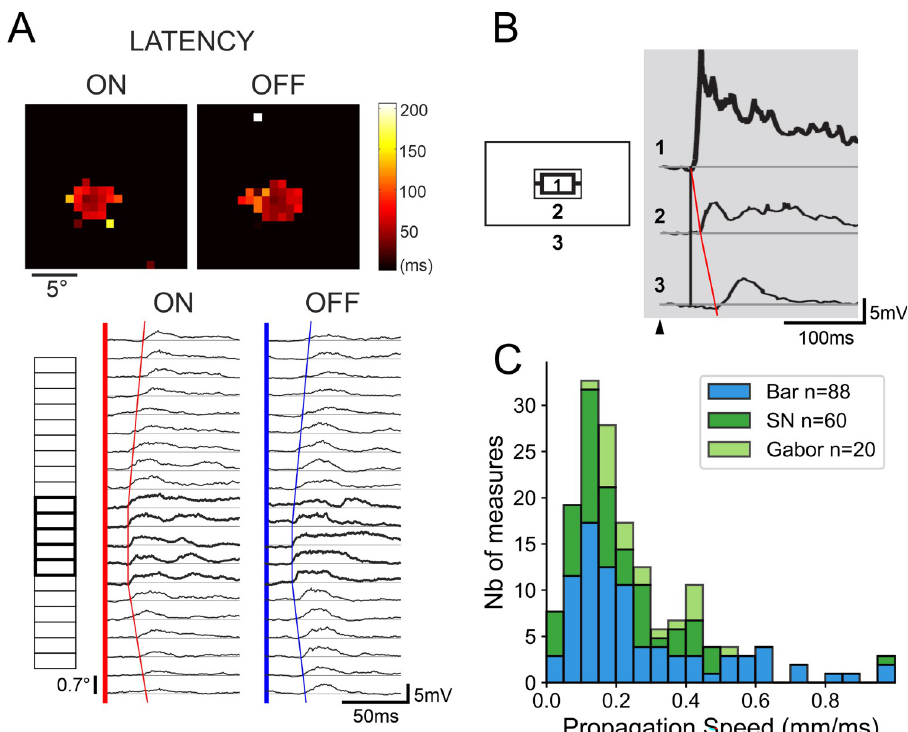
Fig 2. A synaptic view of visual V1 receptive fields. (A) : Latency basin of synaptic responses relative to the RF Center : Top left, spatial maps of the ON- and OFF- Depolarizing Fields latencies using sparse noise (SN) mapping. Heat scale: color code for latency values (from 0 (black) to 200 ms (yellow)). Bottom left, 1D-mapping of ON- and OFF- PSP responses in the same cell, evoked by long bars (7.1˚ x 0.7˚) flashed at the optimal orientation and positioned at different eccentricities (ordinates, ranging from -4˚ (bottom) to +6˚ (top)) across the RF width axis. Thick boxes (along the left ordinate axis) designate the positions which are in overlap with the SRF mapping using SN (above, top left). Red (ON) and blue (OFF) linear regressions illustrate the 1D-latency basin profiles of Surround-Only subthreshold responses. The linear fits of latency versus eccentricity give apparent horizontal speeds of propagation estimates of 0.18–0.38 mm/ms for ON- (red, left) and OFF- (blue, right) responses. (B) Dependency on spatial summation (adapted from [26]): From top to bottom, phase-reversal (2 Hz) responses to disk (1) and annular gratings (2 & 3), for increasing inner border eccentricities from the RF center (5.6˚ in (2) and 10.3˚ in (3)). Note the decay in response strength and the increase of onset latency in Surround-Only responses (2 & 3) with eccentricity (reaching 32 ms for the “Far” Surround annulus). (C) Apparent Speed of Horizontal Propagation (ASHP) distribution : Stacked data histograms from [26] using long bars (1D-mapping, blue) or sparse noise (green), and from this study (Gabor patch maping, light green). Note that, independently of the probe stimulus, most AHSP values inferred from Surround latency basin slopes range between 0.05 and 0.60